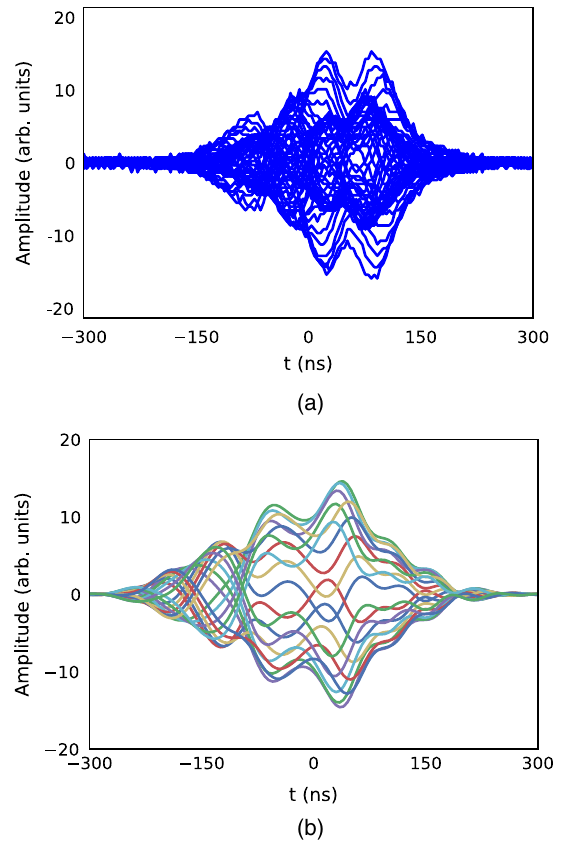
FIG. 11. Head-tail modes as recorded by the horizontal pick-up for a single bunch in the PSB with Q x ¼ 4 . 26 , N ¼ 4 × 10 12 p and ξ x ¼ − 0 . 7 (top), and as predicted by DELPHI simulations for the same parameters (bottom).